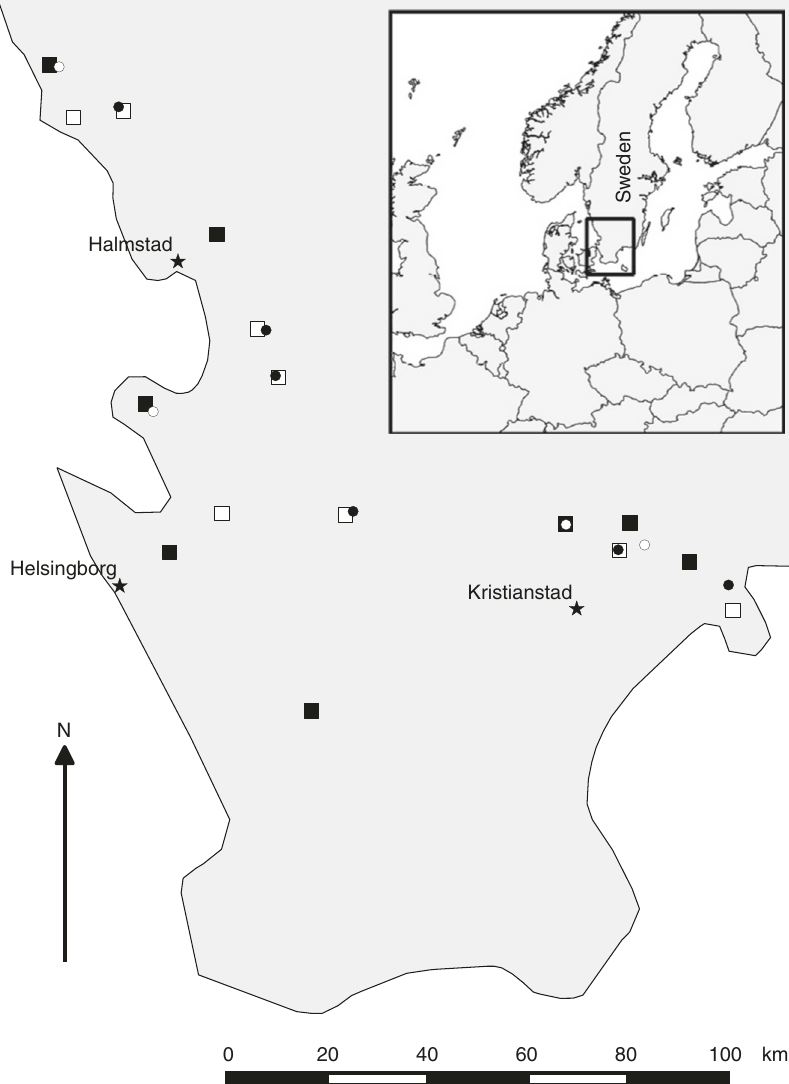
Fig. 1 Study design with replicated landscapes in southern Sweden. In 2013 (squares), 16 oilseed rape fi elds and in 2014 (circles) 10 oilseed rape fi elds were either sown with seeds coated with clothianidin and a fungicide (black) or only a fungicide (control fi elds, white). Stars represent locations of the three weather stations in Supplementary Table 6. The map is based on the World Borders Database (downloadable here: http://thematicmapping.org/